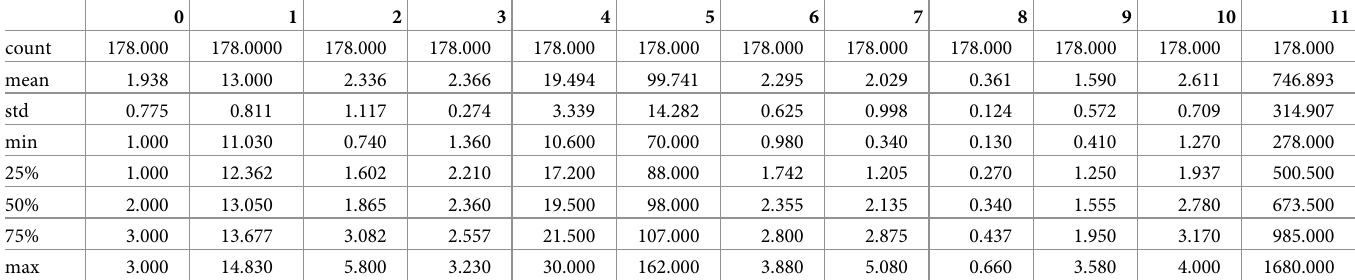
Table 6. Summary statistics of wine data.